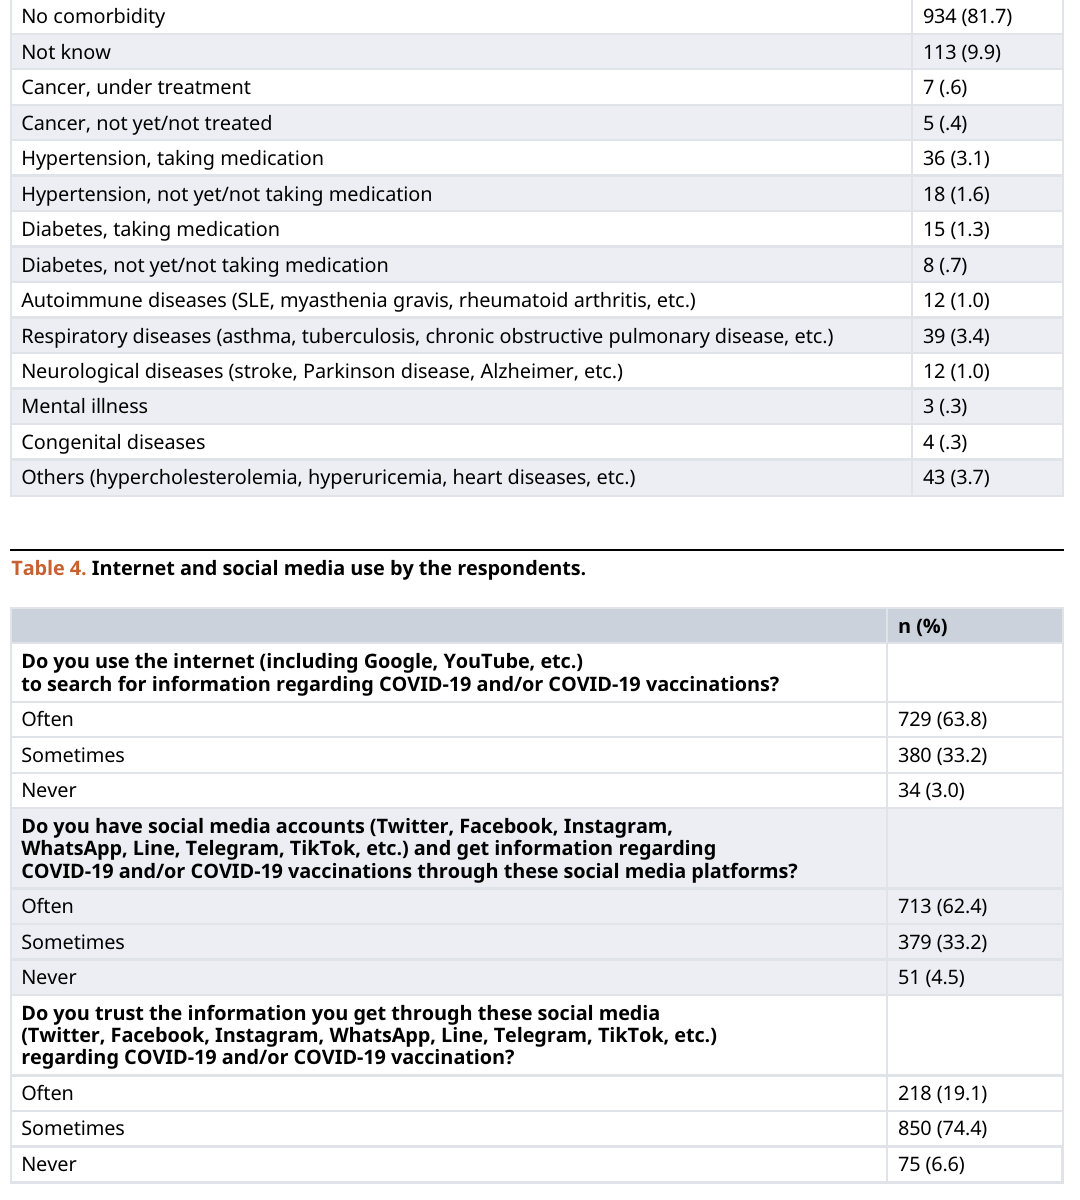
Table 3. Comorbidity stated by the respondents. Comorbidity